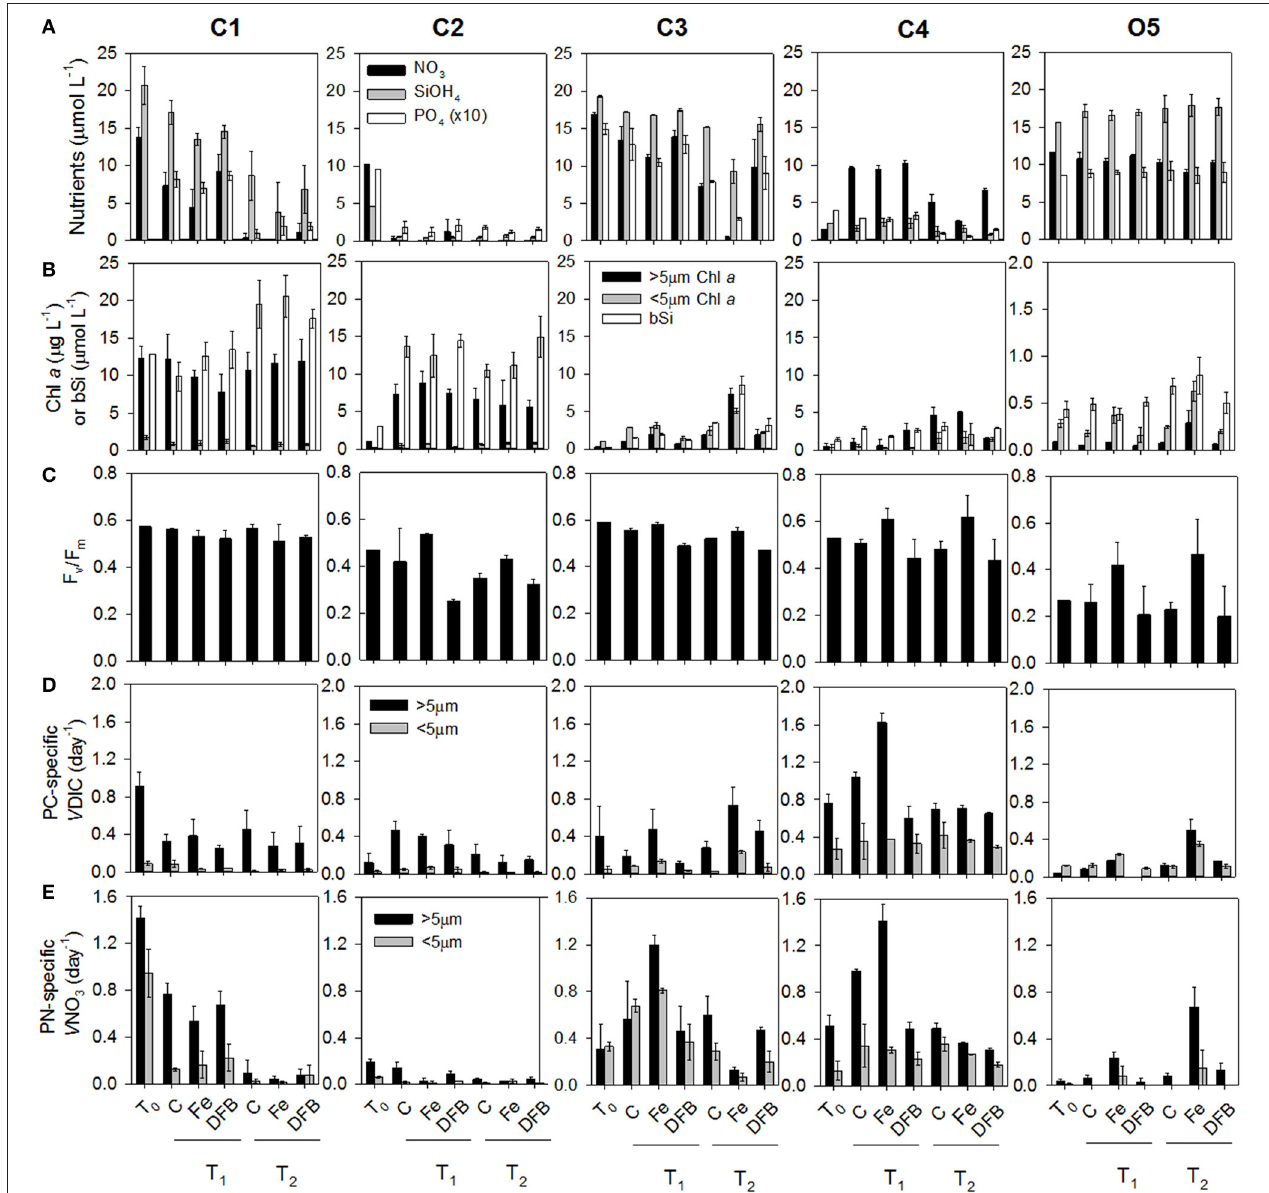
FIGURE 2 | Dissolved macronutrient concentrations: nitrate (NO − 3 ), silicic acid (SiOH 4 ), and ortho-phosphate (PO 3 − 4 ) (A) , Size-fractionated chlorophyll a ( µ g L − 1 ) within the large ( > 5 µ m) and small ( < 5 µ m) size fractions or biogenic silica ( µ mol L − 1 ) (B) , Maximum photochemical yield of PSII (F v /F m ) (C) , Particulate carbon (PC)-specific dissolved inorganic carbon (DIC) uptake rates [ V DIC (day − 1 )] within the large and small size fractions (D) , and particulate nitrogen (PN)-specific nitrate uptake rates [ V NO 3 (day − 1 )] within the large and small size fractions (E) in each treatment and sample time points across sites (see Supplementary Table 1). Where present, error bars represent the standard deviation associated with the mean of triplicate incubations.